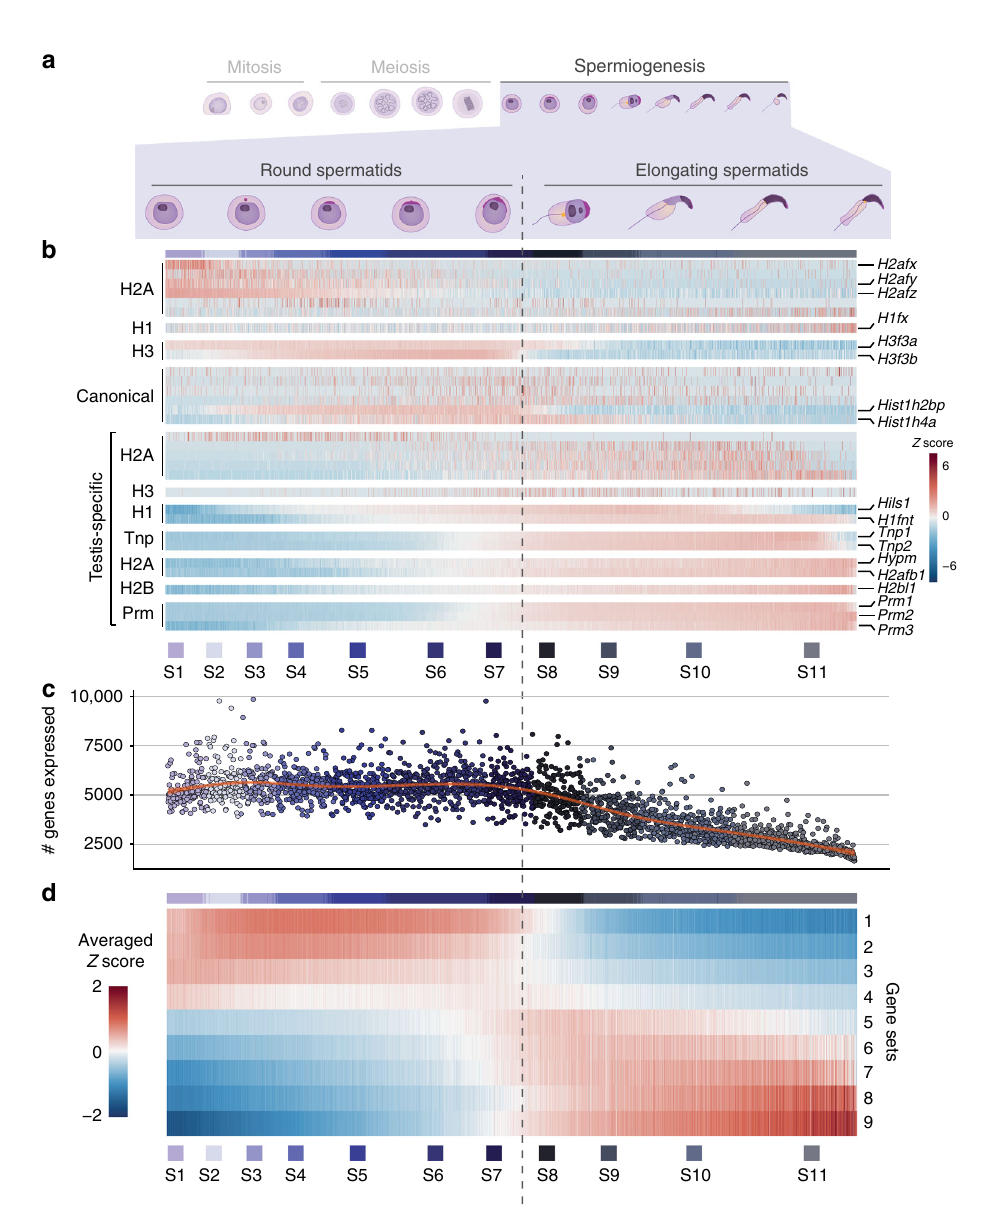
Fig. 6 Transcriptional and chromatin dynamics during spermiogenesis. a Schematic representation of spermiogenesis indicating the round-to-elongating switch that coincides with transcriptional shutdown. b Scaled, normalised expression of histone variants (H1, H2A, H2B, H3), canonical histones, transition proteins (Tnp) and protamines (Prm) during spermiogenesis. Cells were ordered based on their developmental trajectory ranging from round spermatids (S1 – S7) to elongating spermatids (S8-S11). Vertical dashed line indicates transcriptional shutdown between S7 and S8. c Number of genes expressed per spermatid. Cells were ordered based on their developmental trajectory. Red line indicates a smooth regression (loess) fi t. d For each gene, its normalised expression per cell was correlated with the number of genes expressed per cell (Methods). Genes were ordered based on the correlation coef fi cient and grouped into nine sets (Supplementary Data 10). Scaled expression was averaged across genes within each gene